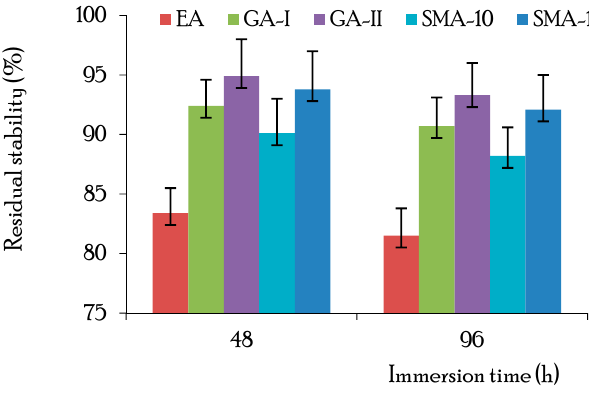
Figure 3. Immersion Marshall stability results for asphalt concretes.